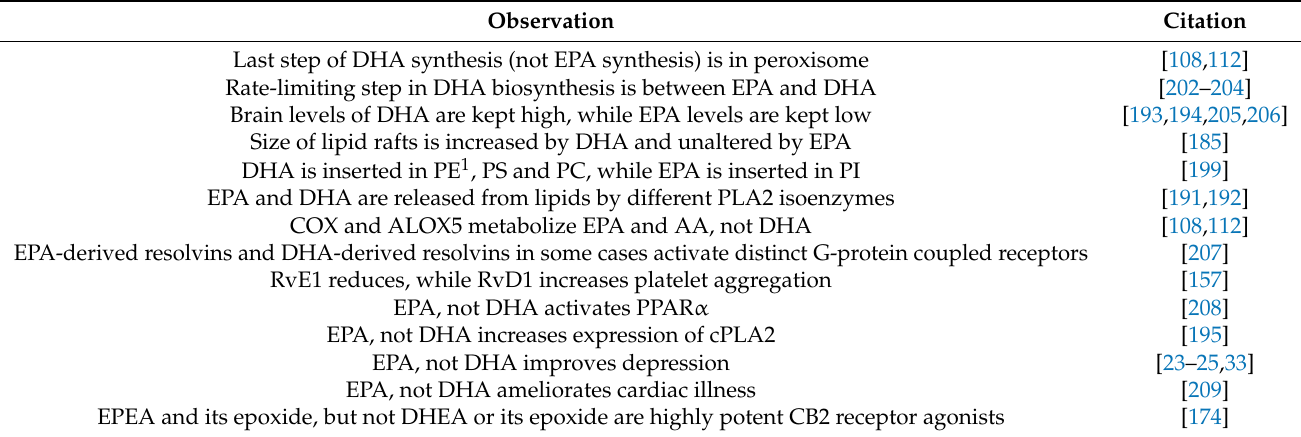
Table 2. List of functional differences between EPA and